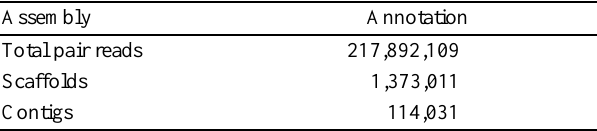
Supplementary Table 1. Assembly and annotation statistics